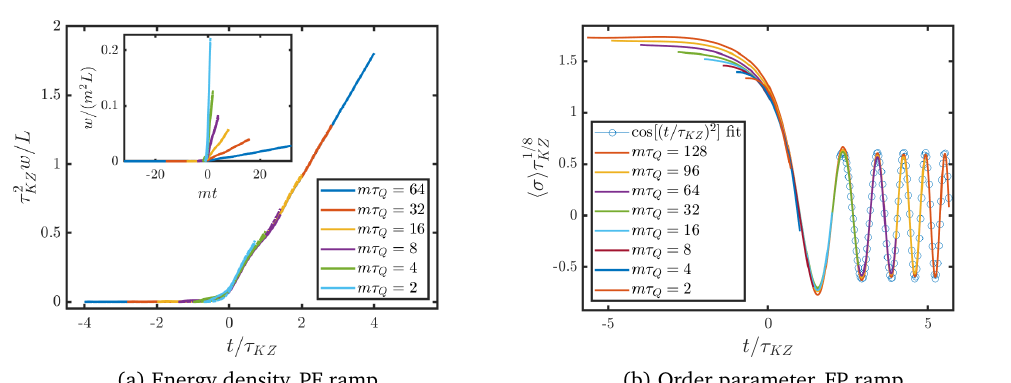
Figure 4.1: Dynamical scaling of the energy density and the magnetisation for ramps along the free fermion line. Solid lines denote exact analytical so- lution while dot-dashed lines represent TCSA results for mL = 50 extrapo- lated in the cutoff. (a) Energy density along ramps of different speed in the paramagnetic-ferromagnetic direction. Inset illustrates the need for rescaling. (b) KZ scaling of the magnetisation σ in the ferromagnetic-paramagnetic direction. The fitted function corresponding to the instantaneous one-particle oscillation is ) = 0.612 ( 2 ) cos (cid:0) ( t /τ ) 2 + 0.830 ( 3 ) (cid:1) . (Note that ( t /τ ) 2 = m ( t ) t f ( t /τ KZ KZ KZ